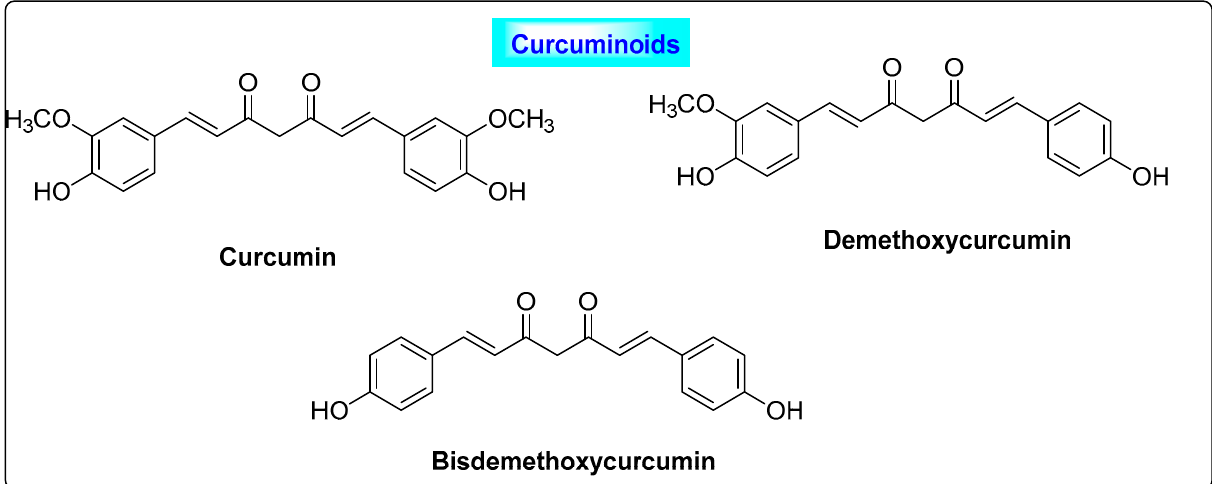
Figure 5. Curcuminoids seen in Curcuma longa responsible for improving the PCOS